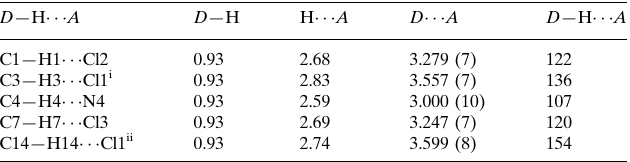
Hydrogen-bond geometry (A˚ , (cid:4)